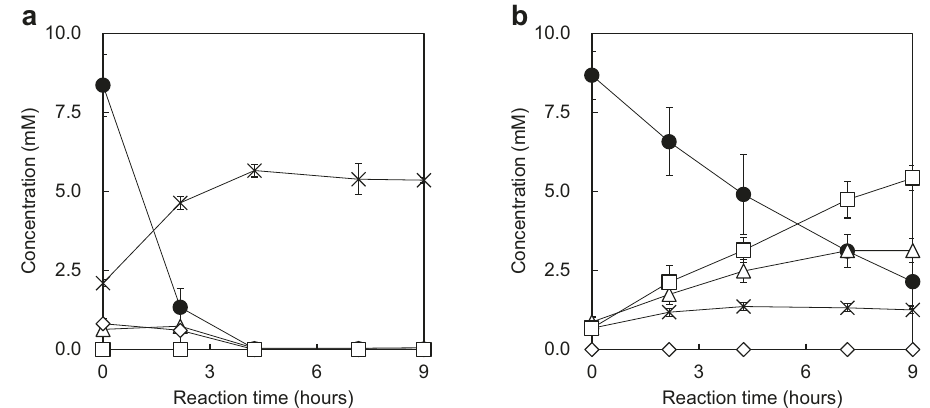
Fig. 1 Analysis of Aib catabolites from R. wratislaviensis C31-06. Time-course of catabolite concentrations, including Aib ( fi lled circles), D -MeSer (empty triangles), Amma (empty squares), L -Ala (empty diamonds), and ammonia (crosses) detected in resting cell reactions a without AOA and b with 1.0 mM AOA. Data represent the mean of three independent